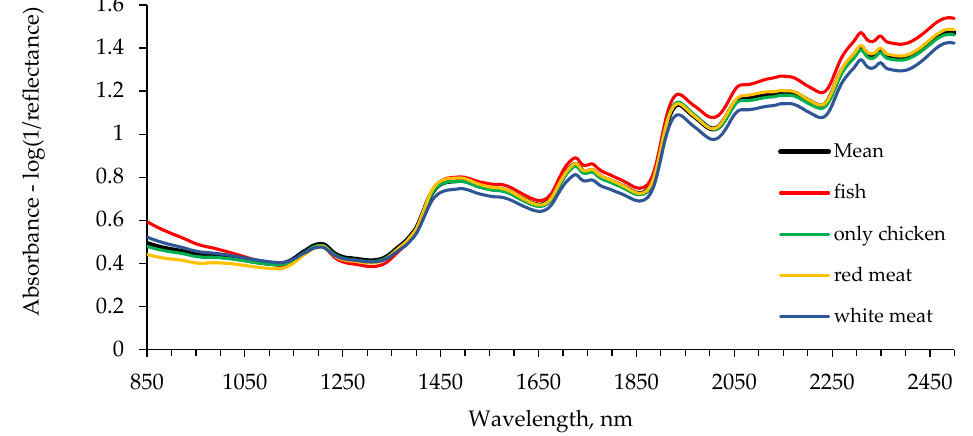
Figure 1. Average raw spectra of extruded dry dog food using near-infrared spectroscopy for the complete dataset ( n = 119), and groups according to the main protein source: Red meat group ( n = 37), fish group ( n = 13), mixed group ( n = 15), chicken group ( n = 29), and white meat group ( n = 21).